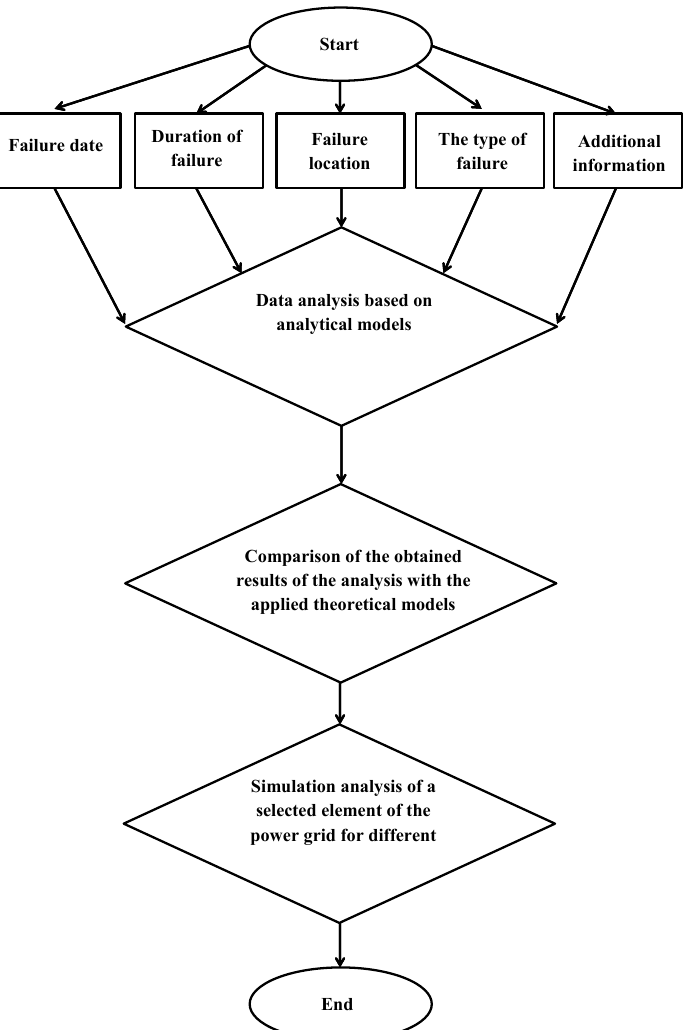
Figure 1. Block diagram of the proposed method of analyzing medium-voltage